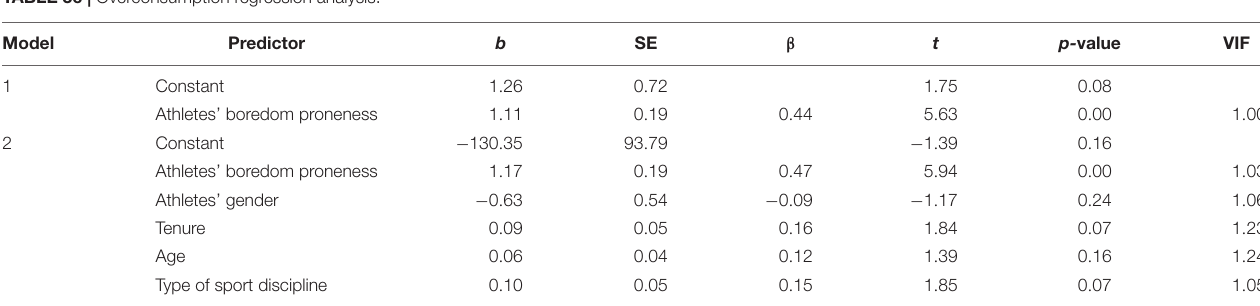
TABLE 3c | Overconsumption regression analysis.